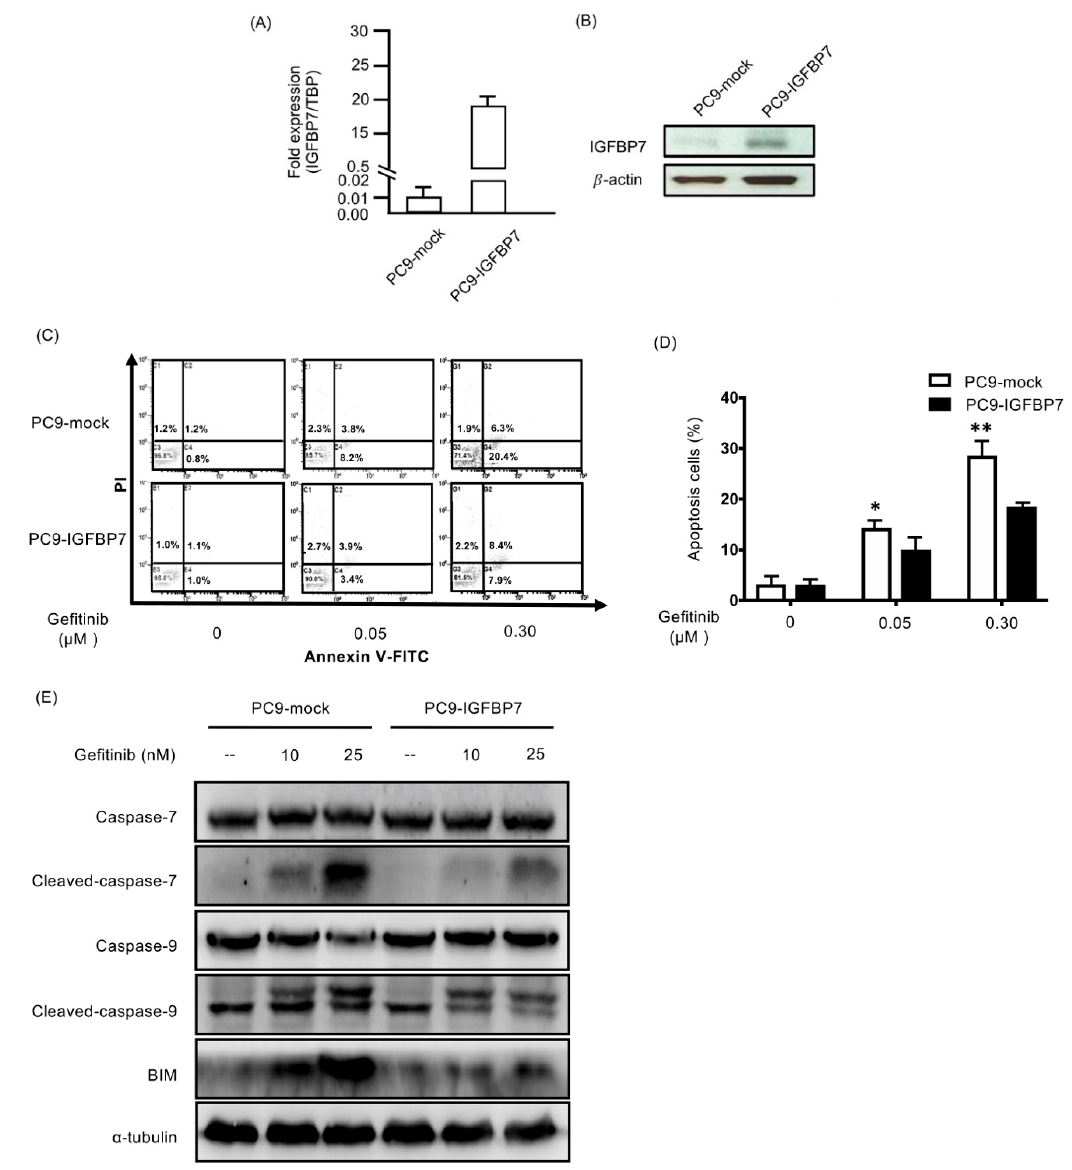
Figure 4. Overexpression of IGFBP7 protects PC9 cells from gefitinib-induced apoptosis. The expression of IGFBP7 in stable transfectants (PC9-mock and PC9-IGFBP7) was evaluated by ( A ) Quantitative RT-PCR and ( B ) Western blot analysis. ( C ) After 48 h of treatment with gefitinib (0 nM, 50 nM and 300 nM), the cells were stained with Annexin V–fluorescein isothiocyanate (FITC) and propidium iodide (PI). The percentage of apoptotic cells was evaluated by flow cytometry. ( D ) The columns show the means of three independent experiments. Error bars show standard deviations (* p < 0.05; ** p < 0.01). ( E ) After 24 h of treatment with 0 nM, 10 nM and 25 nM gefitinib, the apoptotic markers caspase-7, caspase-9, and BIM were evaluated by Western blot analysis.